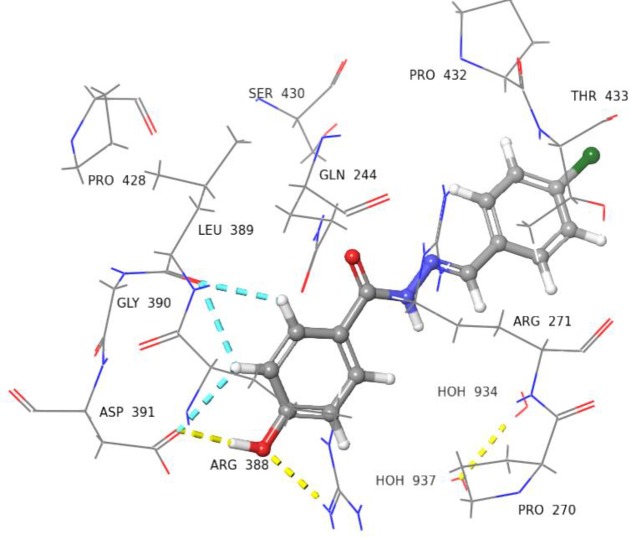
3D Representation of docked pose of compound 9 (IC50 = 159.0 ± 0.4 μM): It is showing interaction with the Asp391, and Arg388 via H-bonds (yellow and blue dotted lines).